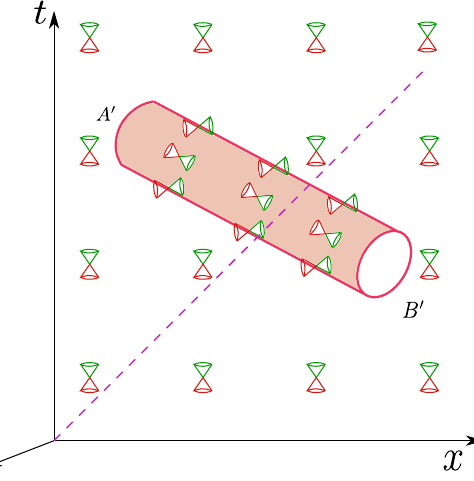
Fig. 3 The figure represents a warp drive tube that starts in a location A (cid:11) and ends in location B (cid:11) . The underlying spacetime can be considered D + 1 dimensional with the warp-drive bubble moving in a straight line (along the x -coordinate, in the picture). In 1 + 1 dimensions the causal conewouldbecomejusttwocrossinglinesbutwekeeptheconesymbol for